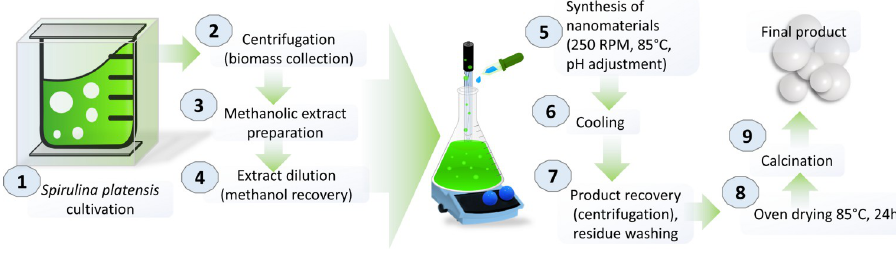
Fig 1. Preparation of nanomaterials from S . platensis